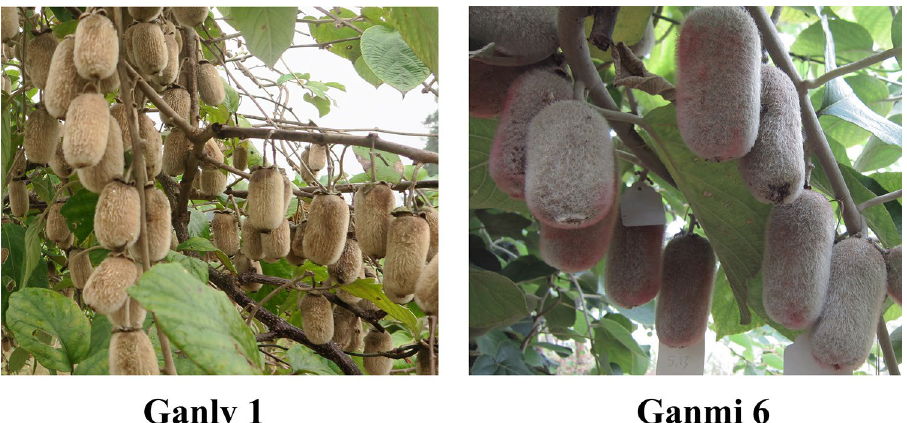
Figure 1. Fruit of test materials. They were cultivated in a kiwifruit orchard located at Fengxin County, Jiangxi